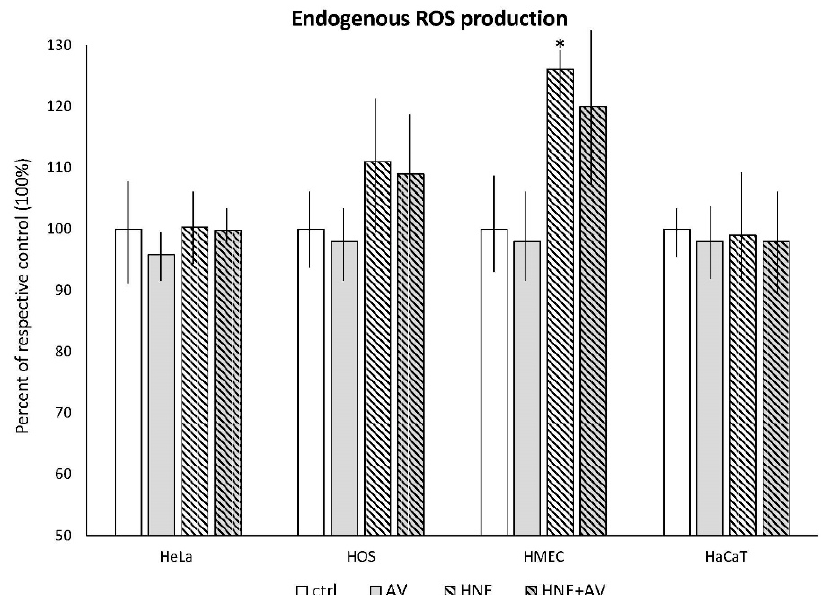
Figure 7. The effects of AV extract (1%) on the cellular generation of reactive oxygen species (ROS; mostly H 2 O 2 ) induced by HNE treatment (50 µ M). The amounts of the HNE–protein adducts were determined using luminescence and are given as mean values for triplicates. * significant difference to respective untreated control.